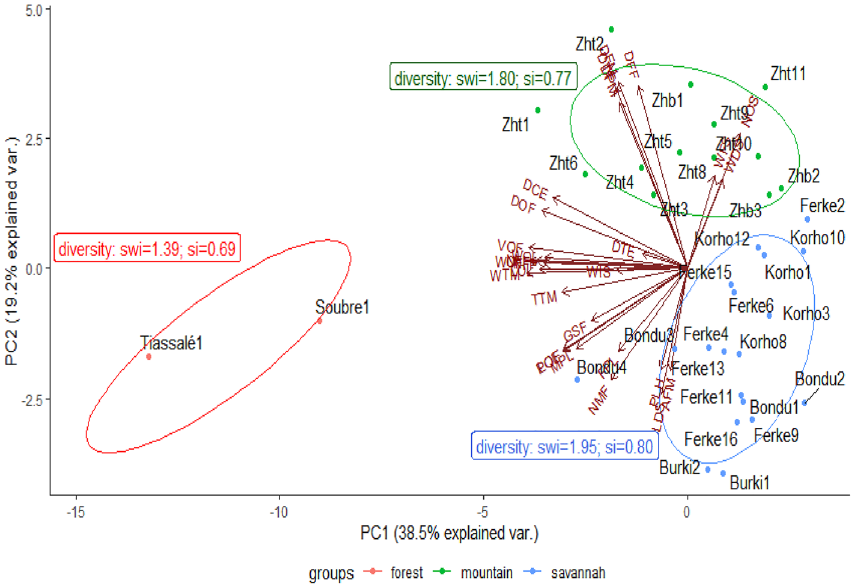
Figure 3. Separation of the morphotypes from the forest, mountain, and savannah regions and vectors of morphological and phenological traits obtained from the principal components analysis along with the diversity indices in each